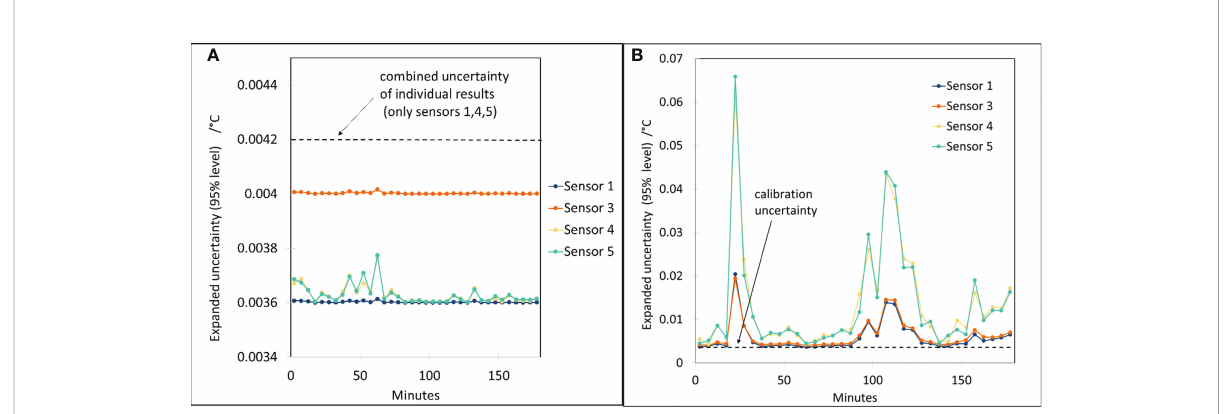
FIGURE 6 Combined uncertainties corresponding to the 5 min means shown in Figure 5. The dashed line in the fi gure on the left-hand side (panel A , low variability period P3), show the approximate combined uncertainties of the individual values (raw data) of sensors 1,4,5 (that of sensor 3 is slightly larger because of its larger calibration uncertainty). The dashed line in the fi gure on the right-hand side (B) approximates the calibration uncertainty of the sensors (high variability P2).